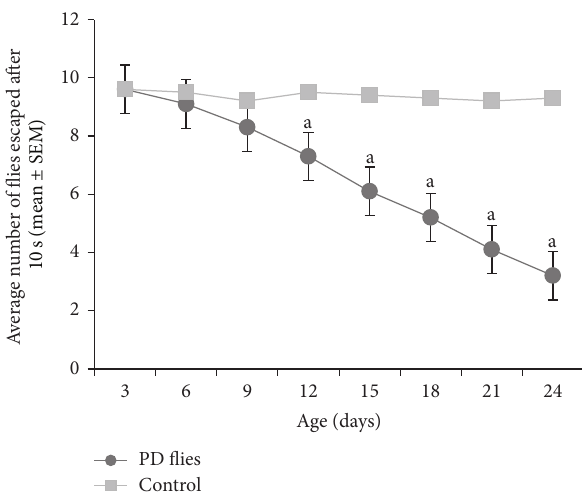
Figure 3: Climbing ability in Parkinson disease (PD) flies and control for a period of 24 days. The values are the mean of five assays ( a significant with respect to control 𝑃 -0.01). Control flies: